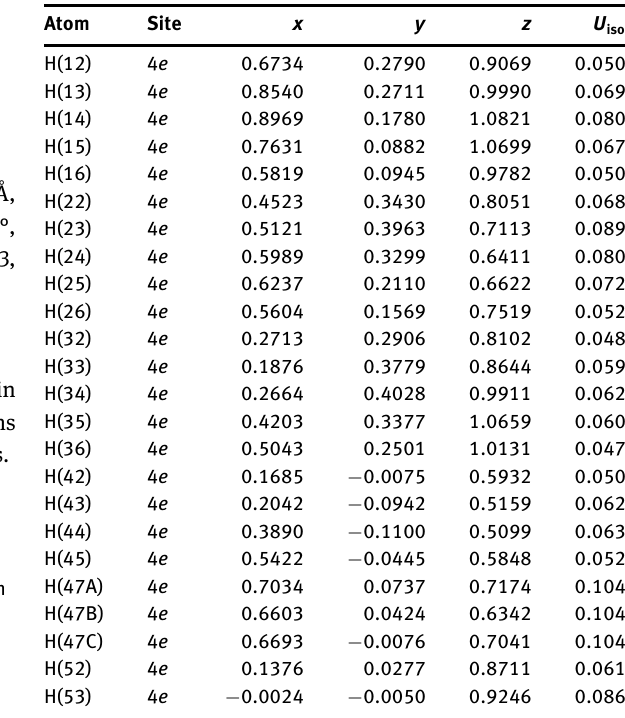
Table 2: Fractional atomic coordinates and isotropic or equivalent isotropic displacement parameters (Å 2